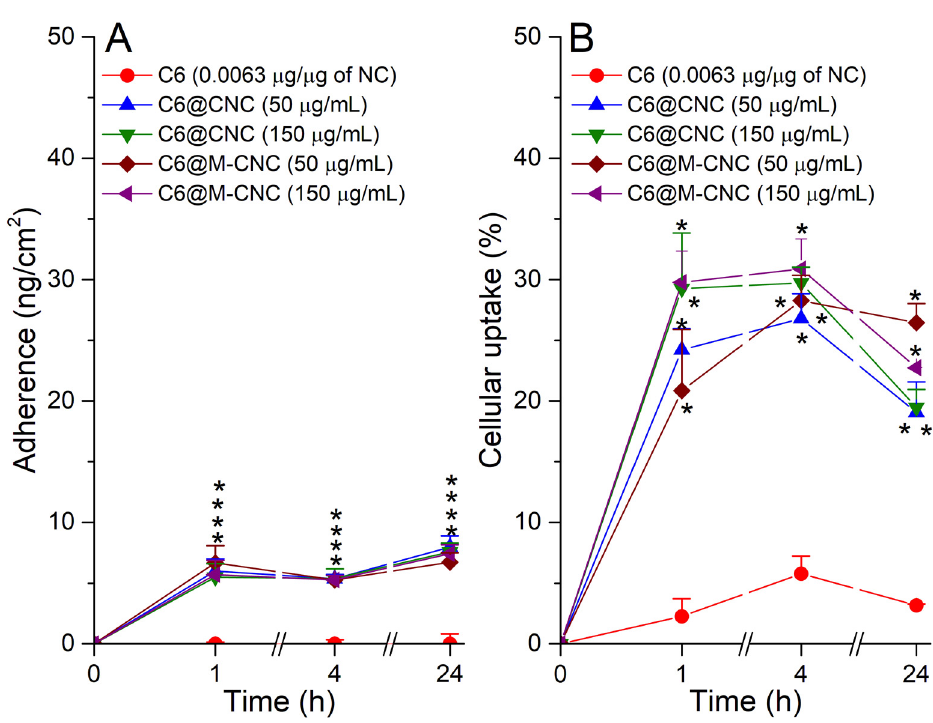
Figure 7. ( A ) Adherence and ( B ) cellular uptake of C6@CNCs and C6@M-CNCs in Caco-2 cells for 50 and 150 µg/mL concentrations. Free C6 (0.0063 µg/µg of NC) was used as a control. Results are expressed as a % of negative control (0 µg/mL) and plotted as mean ± SEM ( n = 3). Data points significantly different ( p < 0.05) from the C6-only values are marked with an